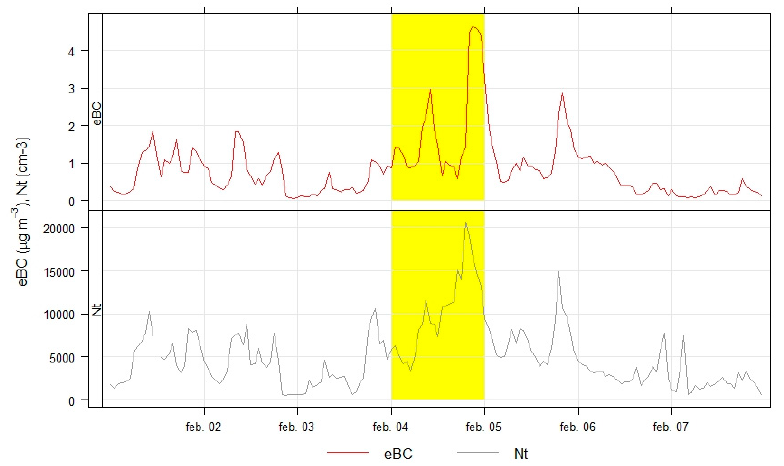
Figure 12. eBC and Nt concentrations during an episode of biomass combustion during 4 February 2016. Another episode with high concentrations of eBC and Nt was detected from 26 Oc- tober to 4 November 2016. In this case, dust and extremely fresh biomass burning episodes during those days were identified. This was confirmed by the high hourly levels found for eBCff and eBCbb (marked in yellow in Figure 13) during this period. With regard to Nt, and as happened with the above-mentioned episode, almost every hourly value are below 20,000 particles cm − 3 during this episode.